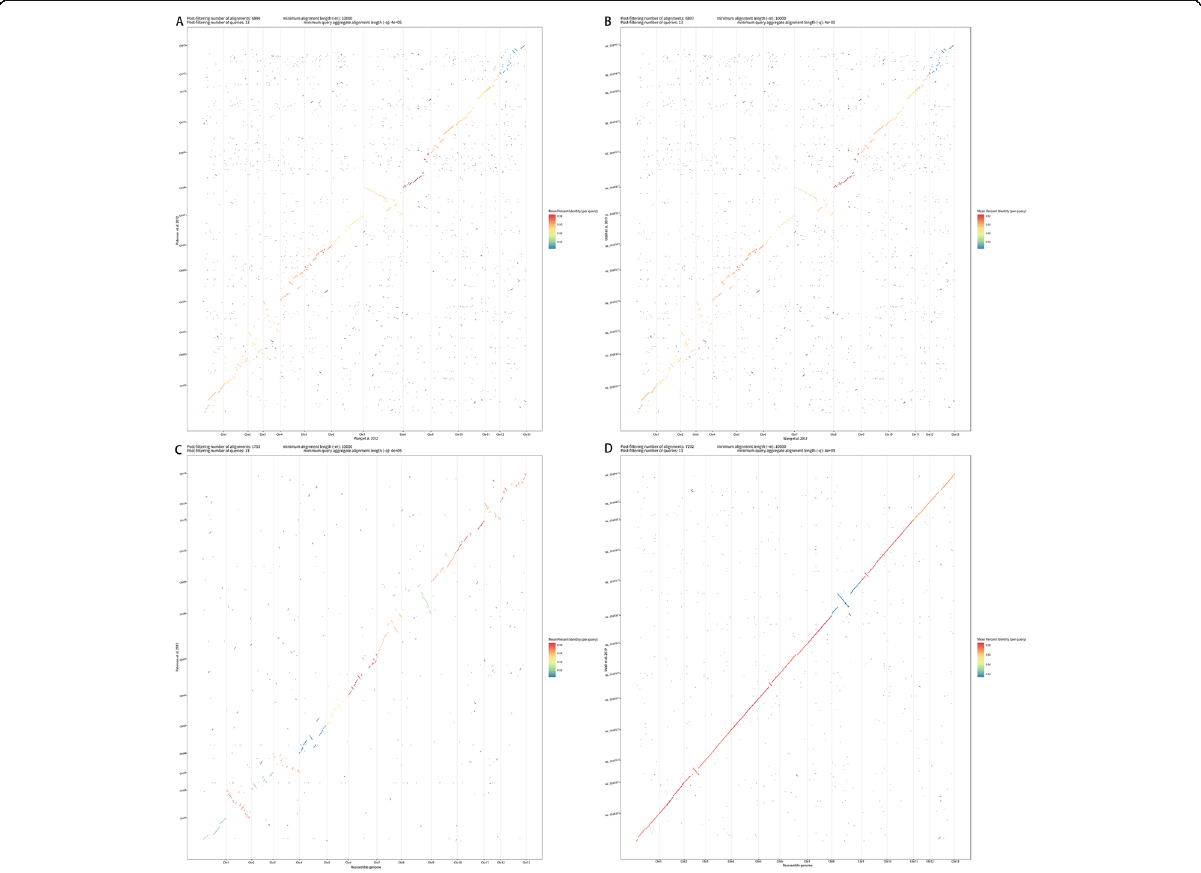
Fig. 2 Genome comparisons between the draft genome and reassembled genome with two previous genome assemblies of G. raimondii. A) Genome alignment between G. raimondii (Wang et al. 2012) and G. raimondii (Paterson et al. 2012). B) Genome alignment between G. raimondii (Wang et al. 2012) and G. raimondii (Udall et al. 2019). C) Genome alignment between G. raimondii (new) and G. raimondii (Paterson et al. 2012). D) Genome alignment between G. raimondii (new) and G. raimondii (Udall et al.